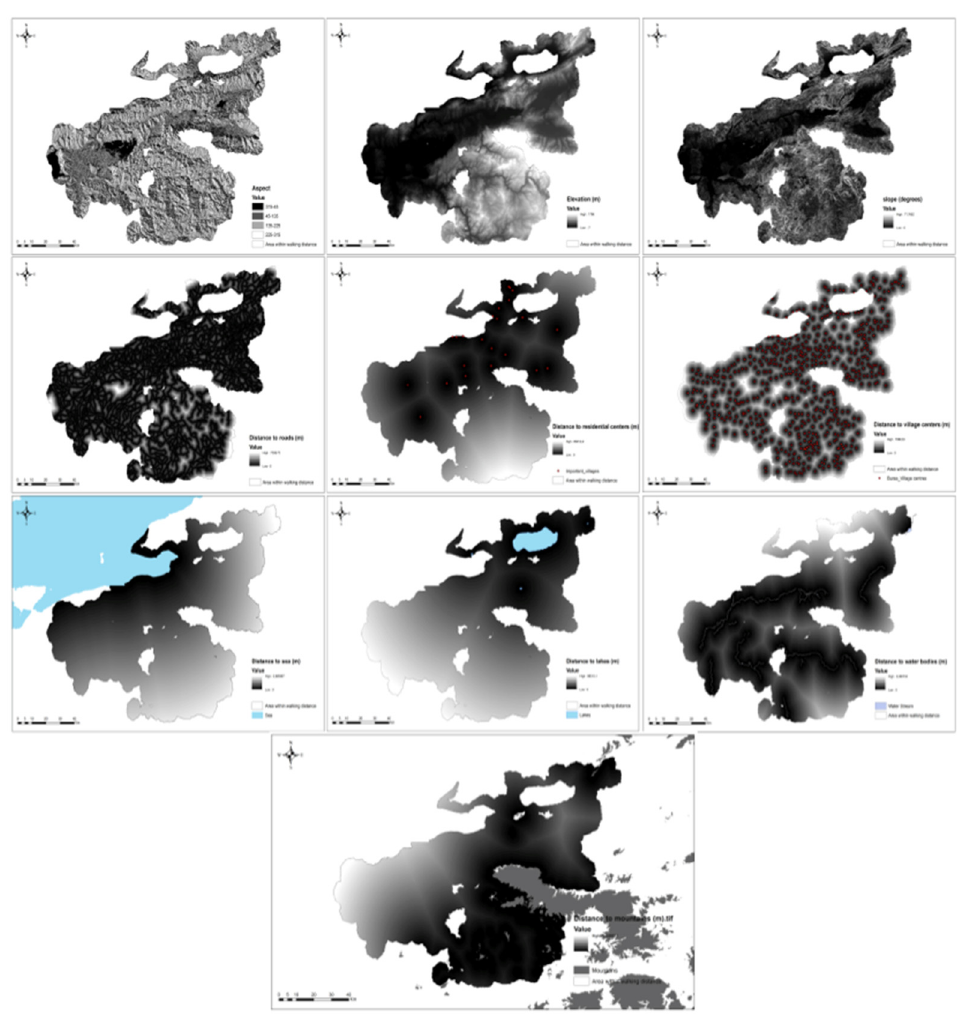
Figure 4. Suitability value maps for each criterion used in the study. Note: The figures represent suitability criteria including from top left to bottom right aspect, elevation, slope, distance to roads, distance to residential centres, distance to villages, distance to the sea, distance to lakes, distance to water bodies and distance to the mountain. The dark colours show the highest suitability areas whereas the light colurs are associated with the lowest suitability.